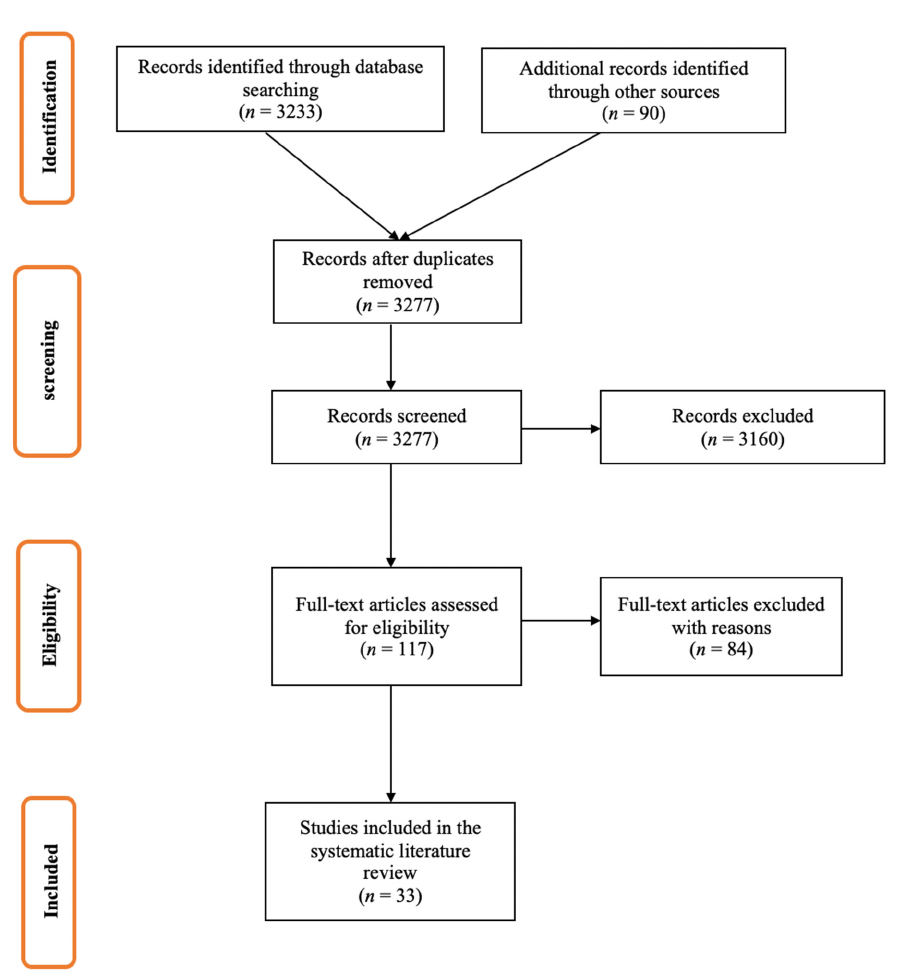
Figure 2. Literature review results for the research question: “Effectiveness of TIV and QIV influenza vaccines in seasons 2014–2019”. Table 3. Comparison of experts’ mean estimates of the absolute increase in vaccine effectiveness in the absence of antigenic drift or egg adaptation changes, per influenza (sub)type and age group, at the EU5 level between 2014 and 2019. Influenza